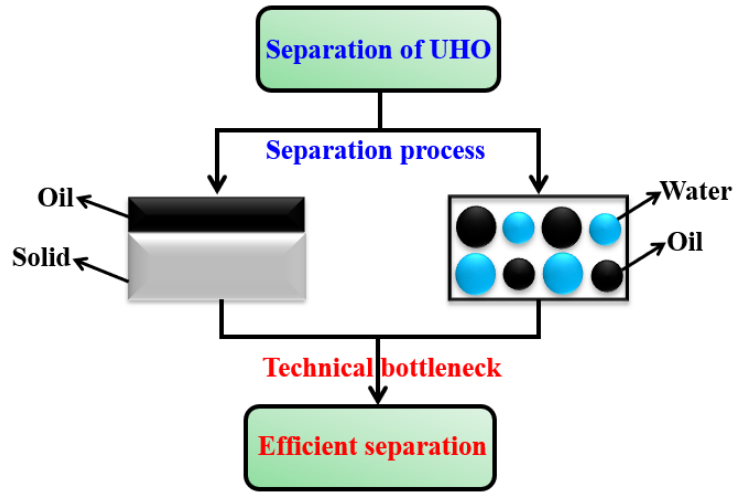
Figure 5. The key technical bottleneck of oil–solid separation and oil–water separation process.